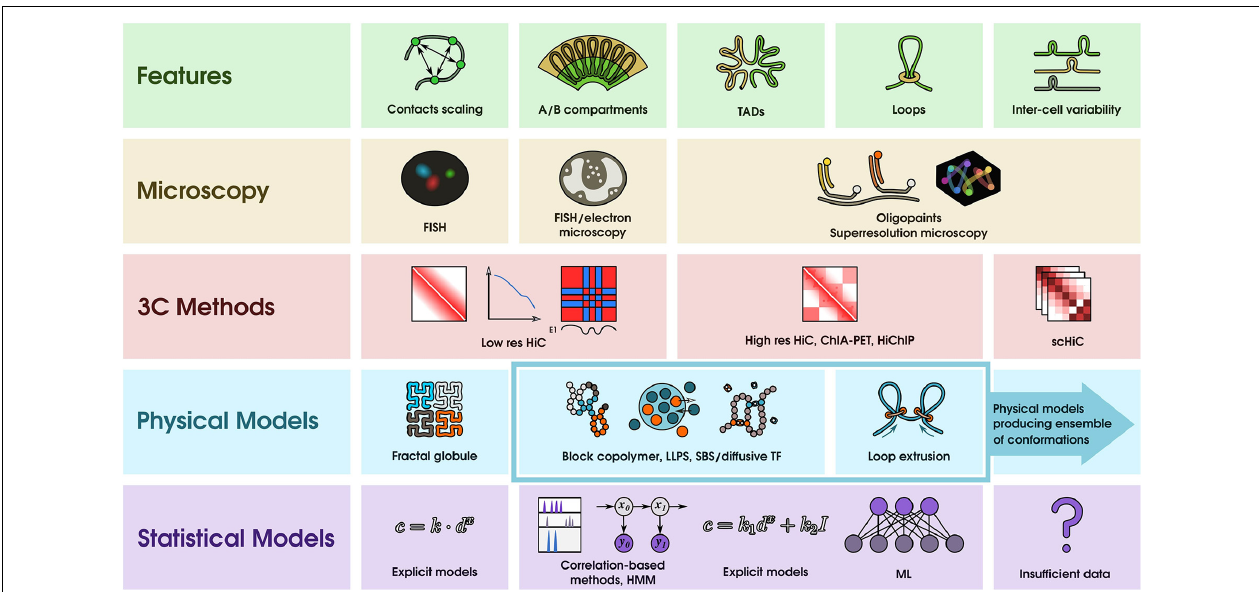
FIGURE 1 | Modeling and predicting the main features of the 3-D-genome organization using physical and statistical approaches. The features row contains a schematic representation of the main features of 3-D-genome organization: scaling of contacts with genomic distance, compartments, TADs, loops, and inter-cell variability of genome architecture (from left to right). The 3C methods row shows that contact scaling and compartments could be found using low-resolution Hi-C data, whereas identification of loops and dissection of TAD structure requires high resolution. Studying inter-cell variability is challenging and could be done using single-cell Hi-C approaches (scHi-C). Microscopy methods shown in the second row include conventional 3D-FISH (fluorescent in situ hybridization) to measure spatial distances; electron microscopy, which is helpful to visualize segregation of eu- and heterochromatin; and modern super-resolution microscopy methods, which, in combination with oligopaints, allow dissection of the internal structure of TADs in individual cells (Boettiger and Murphy, 2020; Szabo et al., 2020). Physical description of chromatin interactions (fourth row) includes generic models such as the fractal globule as well as locus-specific models. For the latter, researchers employ block-copolymer models and models with chromatin binders, such as strings and binders switch (SBS) and diffusive transcription factor (TF) models and concepts of liquid–liquid phase separation (LLPS). All these physical models allow studying the dynamics and inter-cell variability of 3-D structures, providing ensembles of possible chromatin conformations (this is schematically shown in the last cell of the physical models row). Statistical methods (the last row) could utilize interconnections between epigenetic data and chromatin organization using different approaches. This includes approaches in which explicitly defined algebraic expressions contain free parameters, which could be fit from the data, hidden Markov models (HMM), and various machine learning (ML) algorithms. TADs, loops, and compartments were predicted using these methods. However, for single-cell data, these approaches are not applicable, mainly due to the large amount of data required for the implementation of these